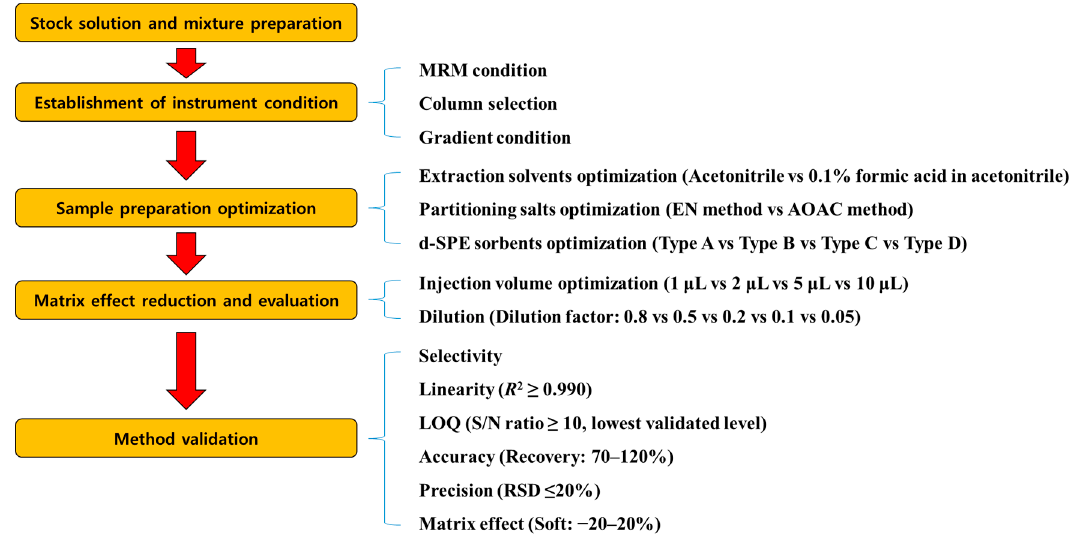
Figure 1. Schematics of the entire experiment.